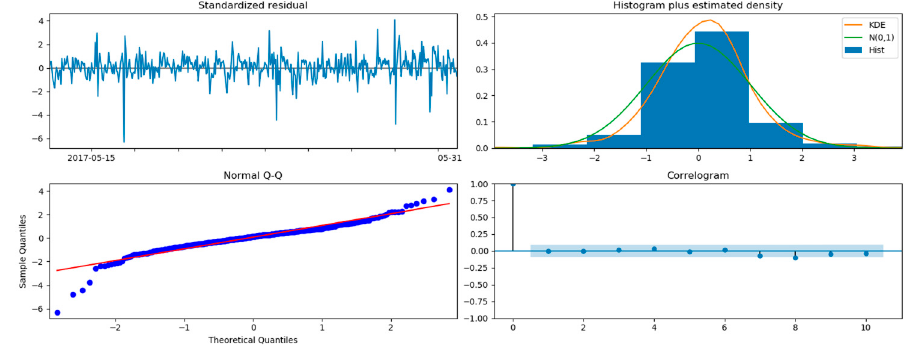
Figure 12. Diagnostic plots for the raw temperature data series obtained from IBIS measurements with a SARIMAX (1, 0, 2) × (0, 1, 2) 24 model.